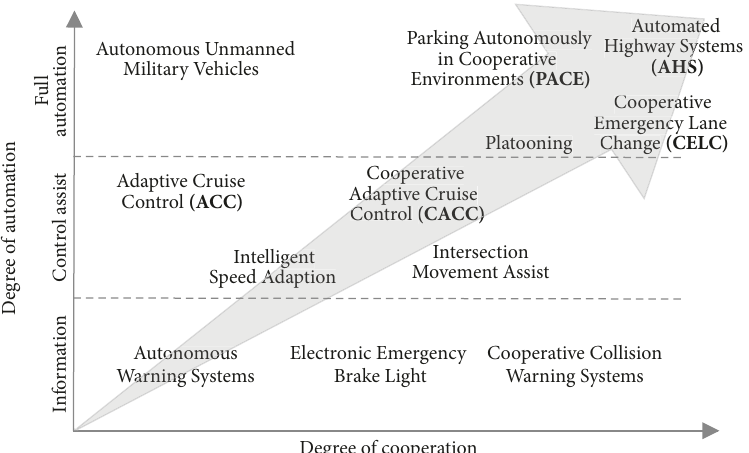
Figure 3: Usefulness of the prototyping environment for developing application, depending on their level of automation and